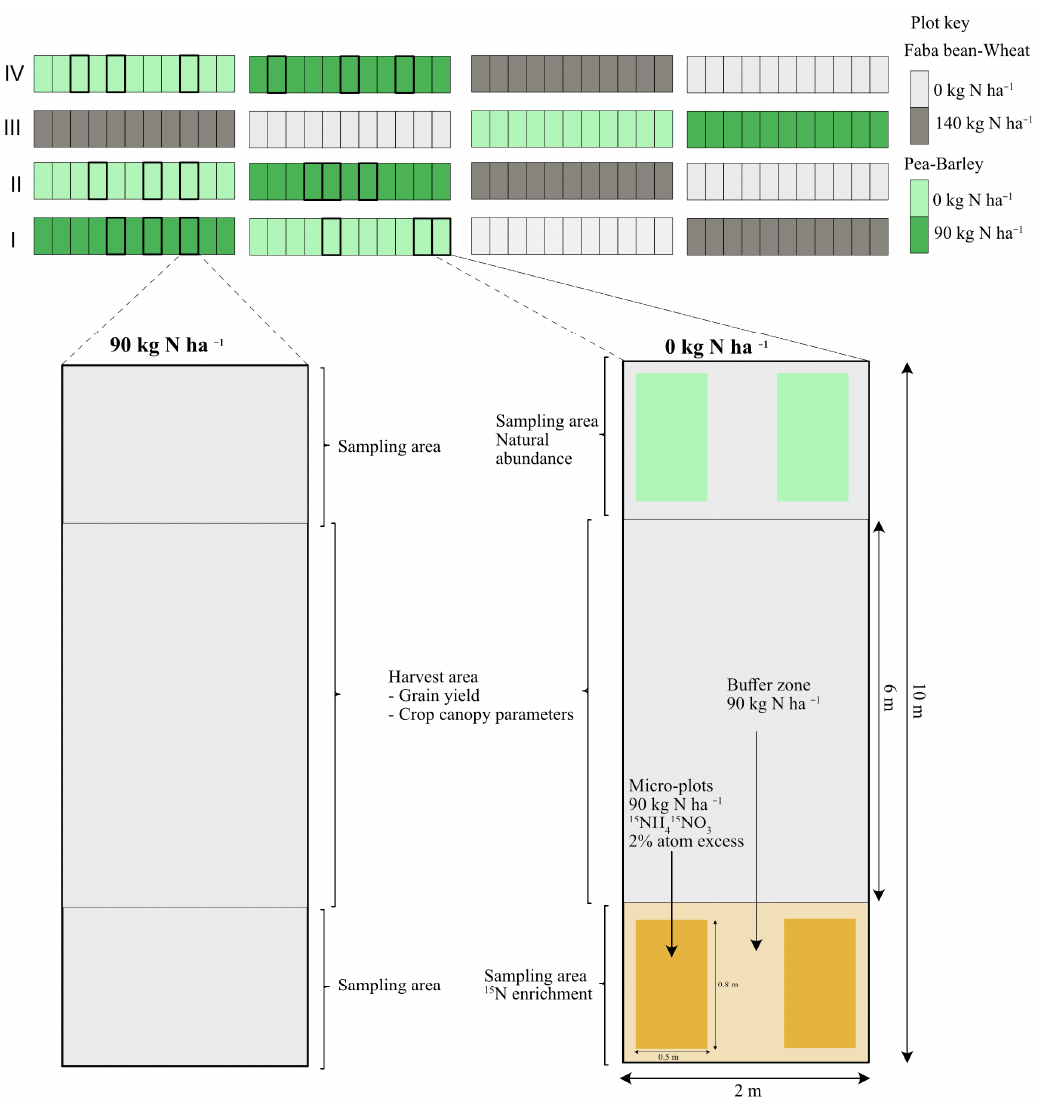
Figure 1. Sketch on the experimental layout for 15 N micro-plots, sampling areas and harvest areas. 15 N-enrichment plots were integrated into the experimental plots that did not receive additional N fertilization (0 kg N ha − 1 ). The plots colored green show pea–barley while grey show faba bean–wheat plots. The light and dark colors denote the different nitrogen treatments.